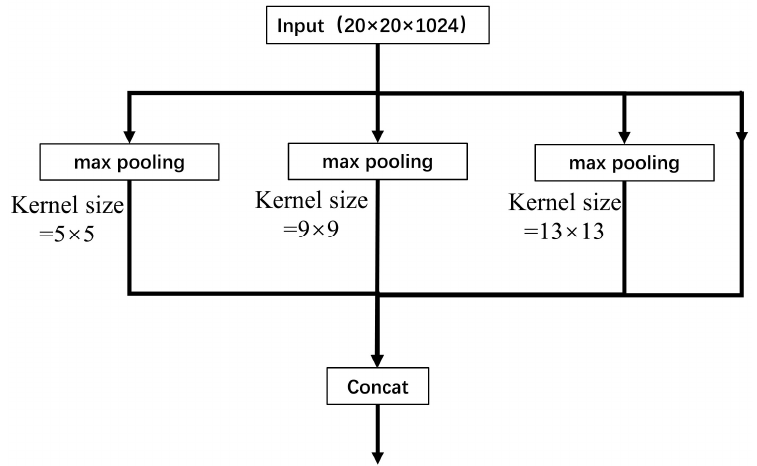
Figure 3. The structure of the SPP.